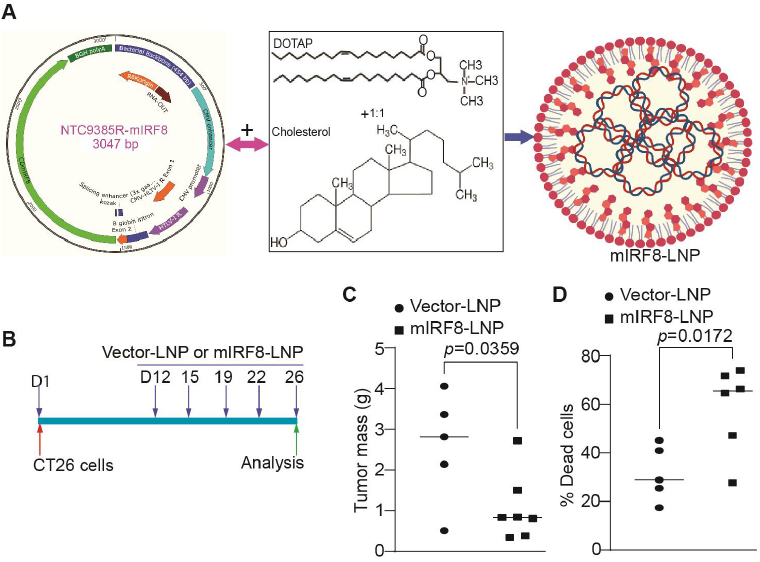
Figure 6. Lipid nanoparticle delivery of IRF8-encoding plasmid DNA to tumor suppresses tumor growth in vivo. ( A ) Formulation of the IRF8-encoding nanoplasmid (NTC9385R-mIRF8) with lipid